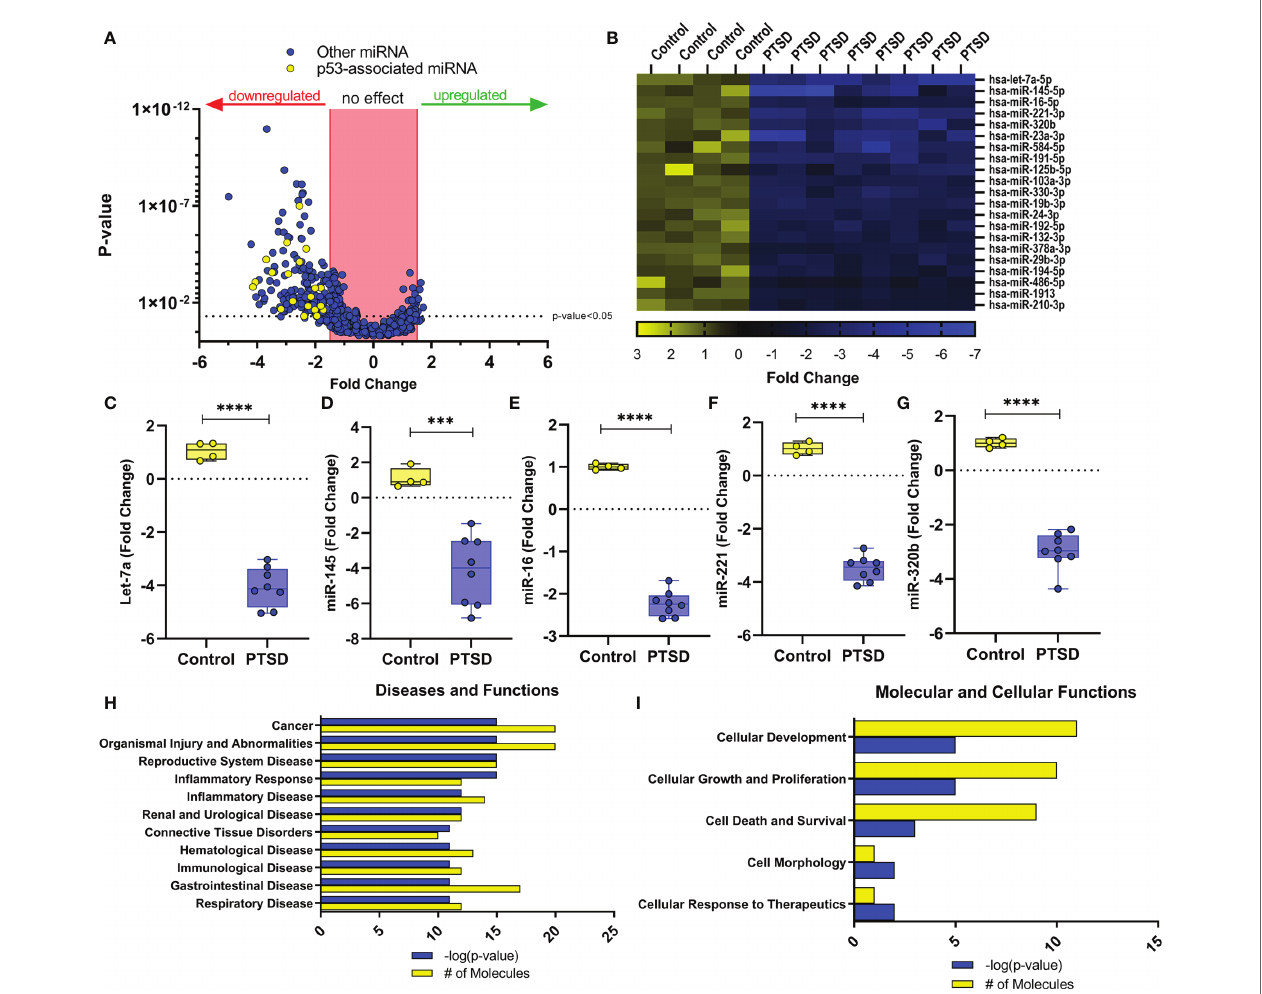
FIGURE 1 | Dysregulated miRNA in PBMCs from PTSD patients are associated with TP53. miRNA array data from PBMCs from Control (n=4) and PTSD subjects (n=8) was analyzed using IPA analysis software. (A) Volcano plot depicting miRNA fold change values (x-axis) of PTSD vs. Control plotted against p-values (y-axis). Yellow dots represent TP53-associated miRNAs. (B) Heat Map depicting 21 TP53-associated miRNA that were signi fi cantly downregulated in PTSD samples compared to control. (C – G) Box and whisker plots depicting top 5 downregulated TP53-associated miRNA between Control and PTSD samples to include (C) let-7a, (D) miR-145, (E) miR-16, (F) miR-122, (G) miR-321b. Box and whisker bars depict maximum and minimum values, with middle bar depicted at the median. (H, I) Top ranked networks (as determined by IPA-derived – log p-values and # of molecules) for 21 total dysregulated miRNA associated with TP53 to include (H) Disease and Functions, as well as I) Molecular and Cellular Functions. Signi fi cance in linear fold change was determined as any value ≥ 1.5 or ≤ -1.5 fold, and p-value was determined signi fi cant if this value ≤ 0.05 using an unpaired standard t test. P-values: ≤ 0.005 (***), ≤ 0.001